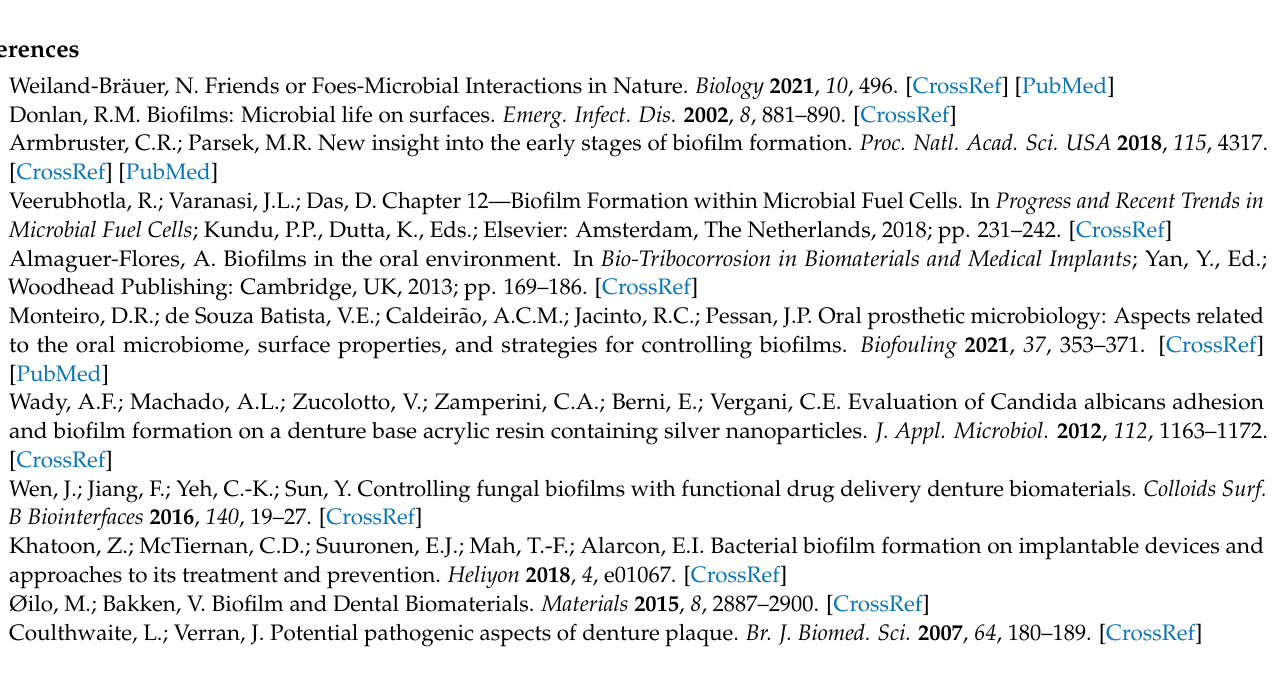
Table S2: The contact angle measurements for all three groups’ samples, including the following information: the frame number, time (s), left and right angles ( ◦ ), left and right root mean squared error (RMSE), left and right contact points (pixels), and droplet width (pixels). Table S3: The contact angles for each sample of the three groups after the 2 min